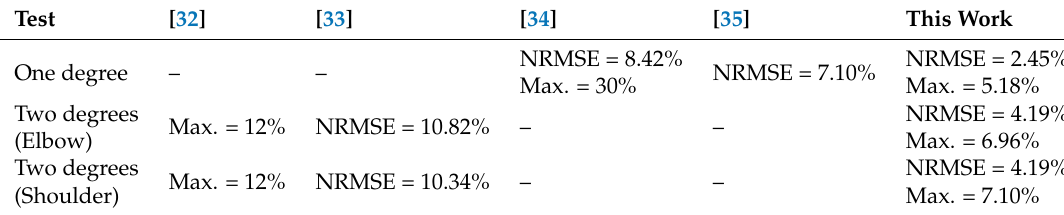
Table 3. Comparison with related